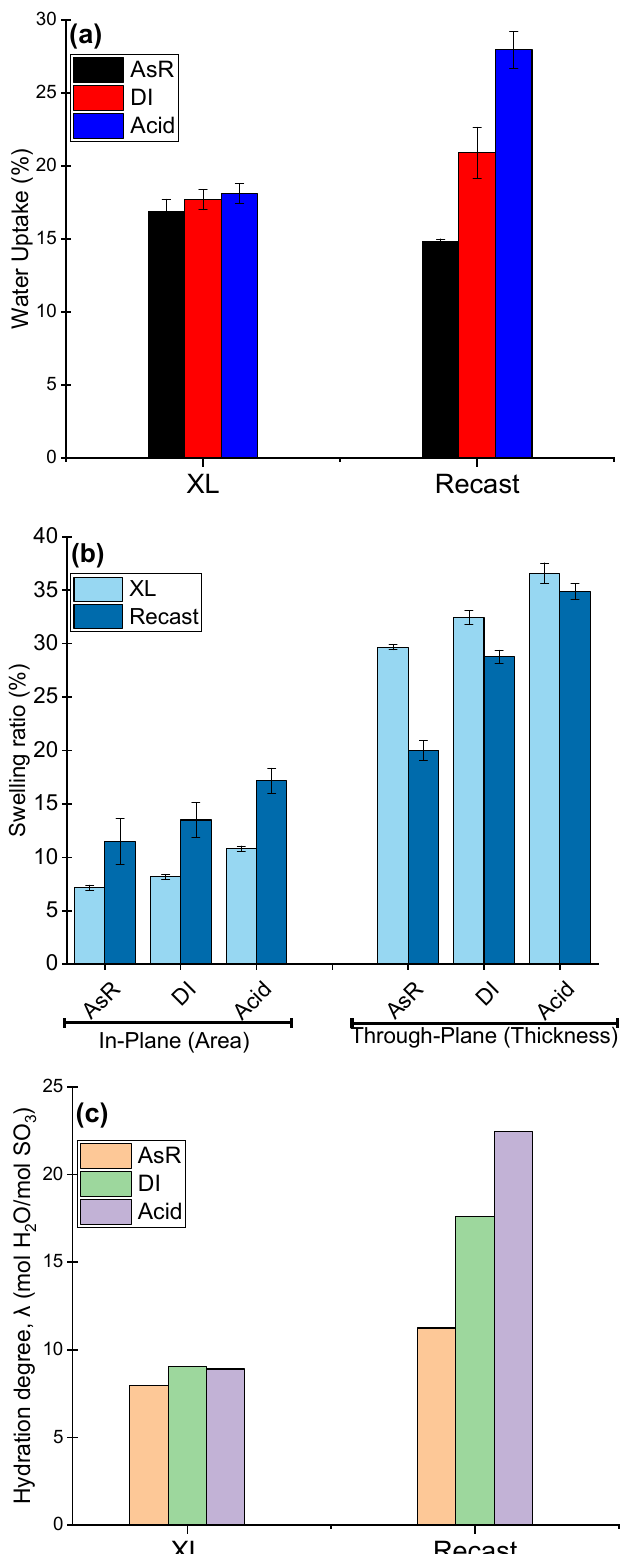
Figure 2. Hydration properties for re-cast Nafion and Nafion XL at different treatment, ( a ) Water uptake, ( b ) Dimensional swelling ratio, ( c ) Hydration degree.